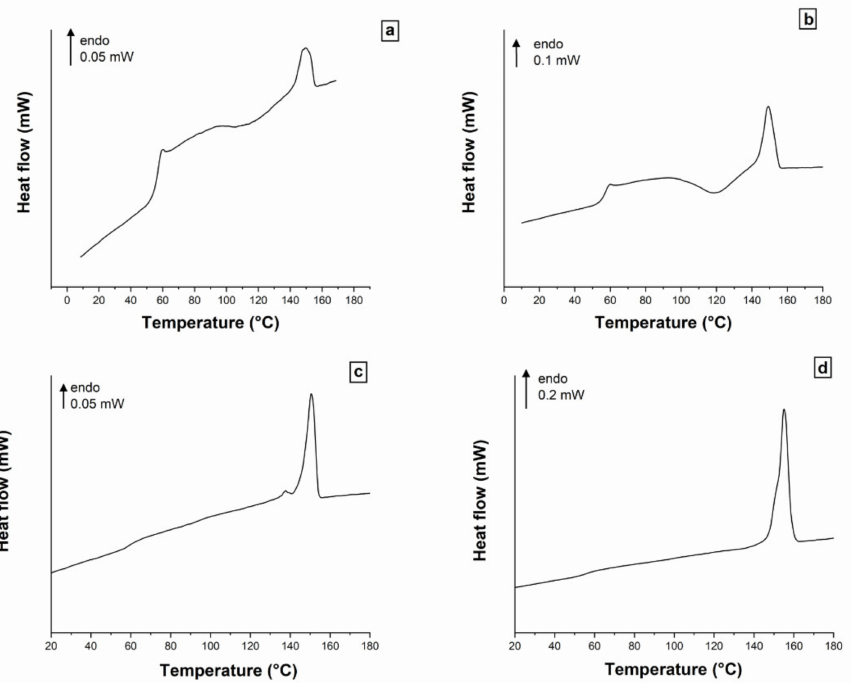
Figure 1. MT-DSC responses of ( a ) amorphous PLA before immersion, ( b ) amorphous PLA after 2 months of immersion FESEM, ( c ) PLA crystallized 7 days at 80 ◦ C and immersed 2 months, ( d ) PLA crystallized 7 days at 135 ◦ C and immersed 2